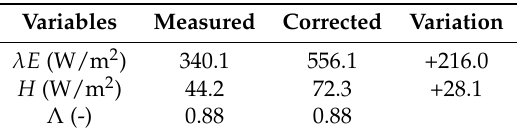
Table 3. Measured and corrected heat flux densities at the Yingke station for the 7 July 2008 at 11:30 a.m. (Beijing time).